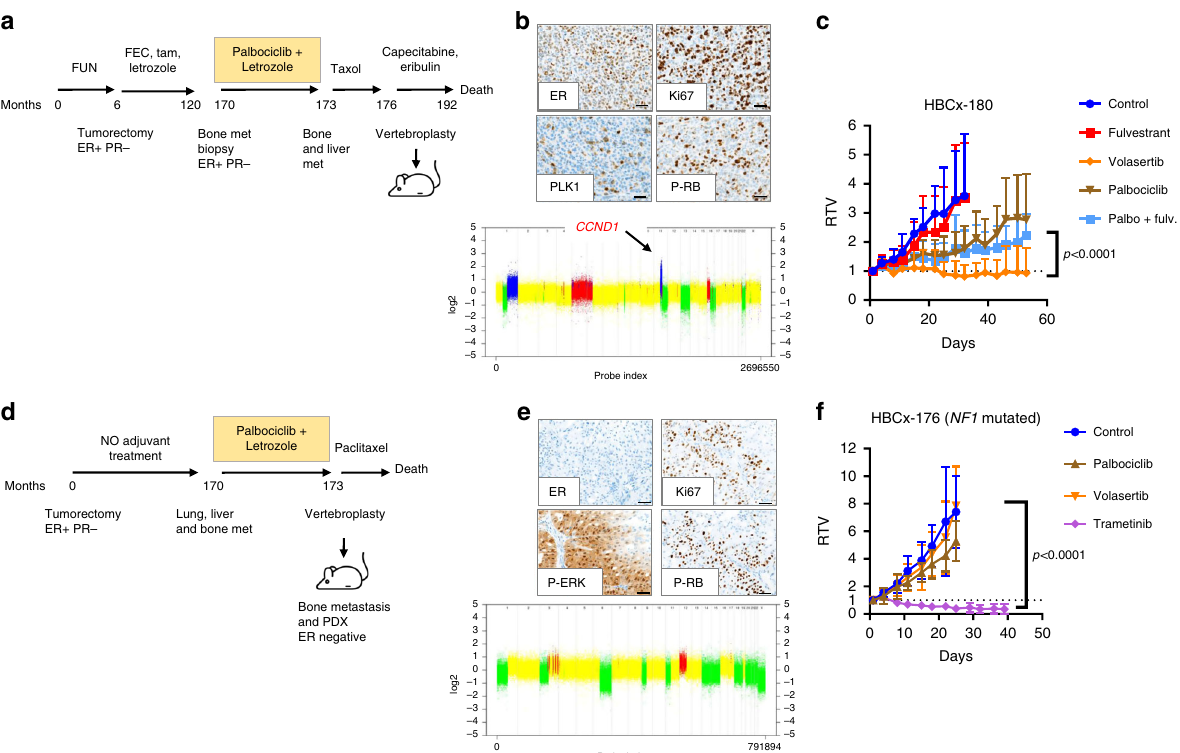
Fig. 4 Response to treatment of PDX established from breast cancer patients progressing on palbociclib treatment. a Clinical history of the patient corresponding to HBCx-180 PDX: the patient was treated by neo-adjuvant chemotherapy and adjuvant chemotherapy + endocrine treatment (tamoxifen and letrozole). The patient recurred with bone metastases 14 years after diagnosis and was treated by palbociclib + letrozole during 3 months followed by paclitaxel before vertebroplasty and PDX establishment. b Immunohistochemical analysis of Ki67 (54% of positive cells), PLK1 (10% of positive cells), ER (95% of positive cells) and phospho-RB (37% of positive cells) in PDX HBCx-180 and copy number pro fi le (Cytoscan HD array). c Response to fulvestrant, palbociclib, palbociclib and fulvestrant and volasertib in PDX HBCx-180. Mean ± SD ( n = 5 fulvestrant treated group; n = 6 in the other groups). P ≤ 0.0001 (Mann – Whitney t test, volasertib versus palbo + fulv., two-sided). d Clinical history of the patient corresponding to HBCx-176 PDX: the breast tumour was removed by tumorectomy and was ER + PR − . The patient did not received adjuvant endocrine treatment, recurred with bone, liver and lung metastases 14 years after diagnosis and was treated by palbociclib + letrozole during 3 months before vertebroplasty and PDX establishment. e IHC analysis of ER (0% of positive cells), Ki67 (54% of positive cells), P-ERK (70% of positive cells) and P-RB (47% of positive cells) and copy number pro fi le (Cytoscan HD array). f Response to trametinib, palbociclib and volasertib in PDX HBCx-180. Mean± SD; n = 7 for control, palbociclib, volasertib, n = 8 in trametinib group. P ≤ 0.0001 (Mann – Whitney t test, volasertib versus palbo +